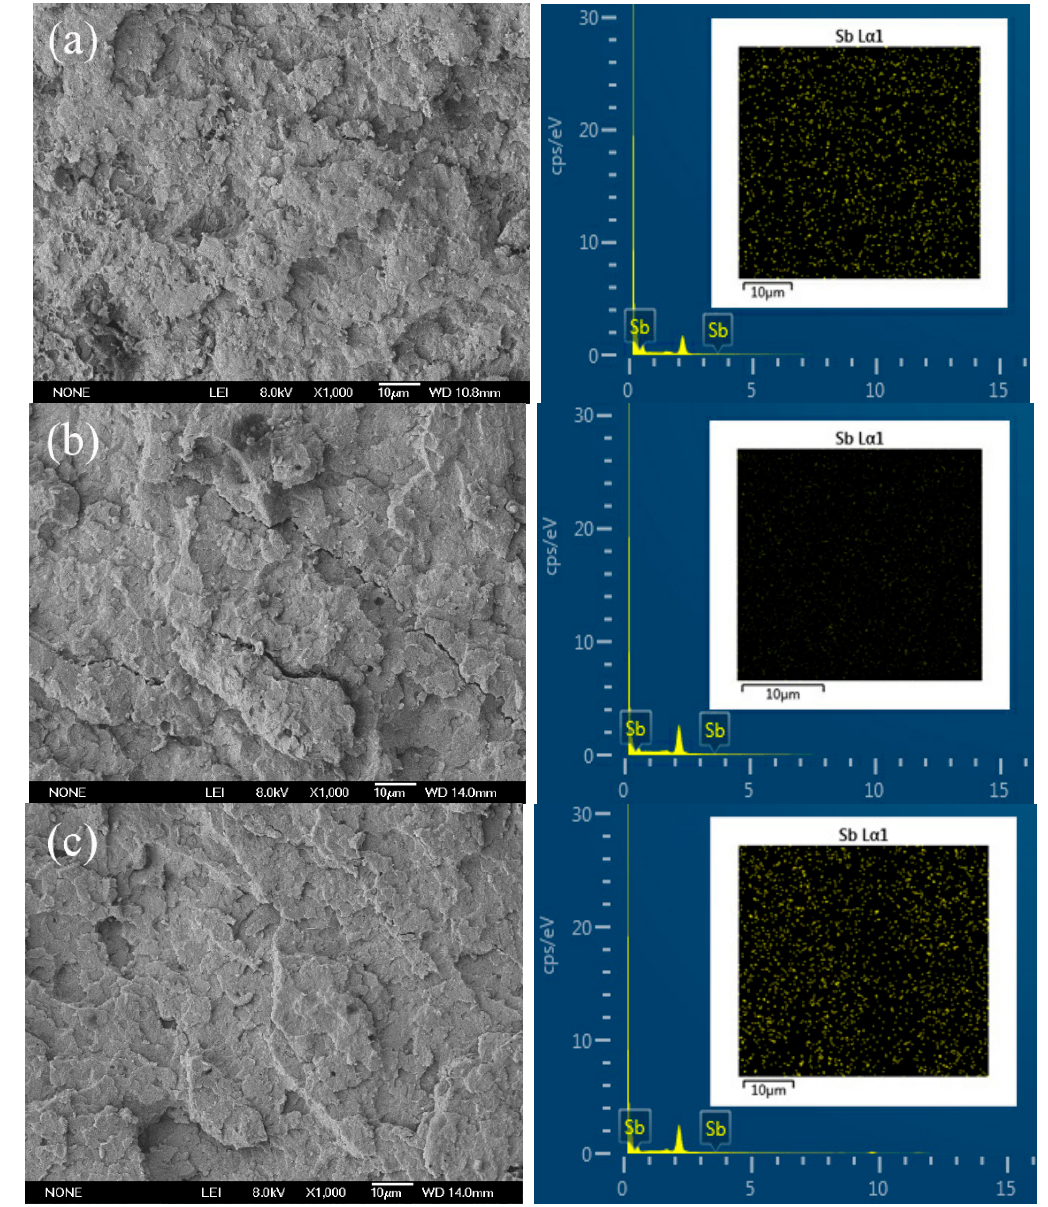
Figure 2. Scanning electron microscopy (SEM) micrographs and energy dispersive spectrometry (EDX) images of nanocomposites fractured surfaces. ( a ) 1 wt % nano-Sb 2 O 3 composites, ( b ) 3 wt % nano-Sb 2 O 3 composites, and ( c ) 5 wt % nano-Sb 2 O 3 composites.